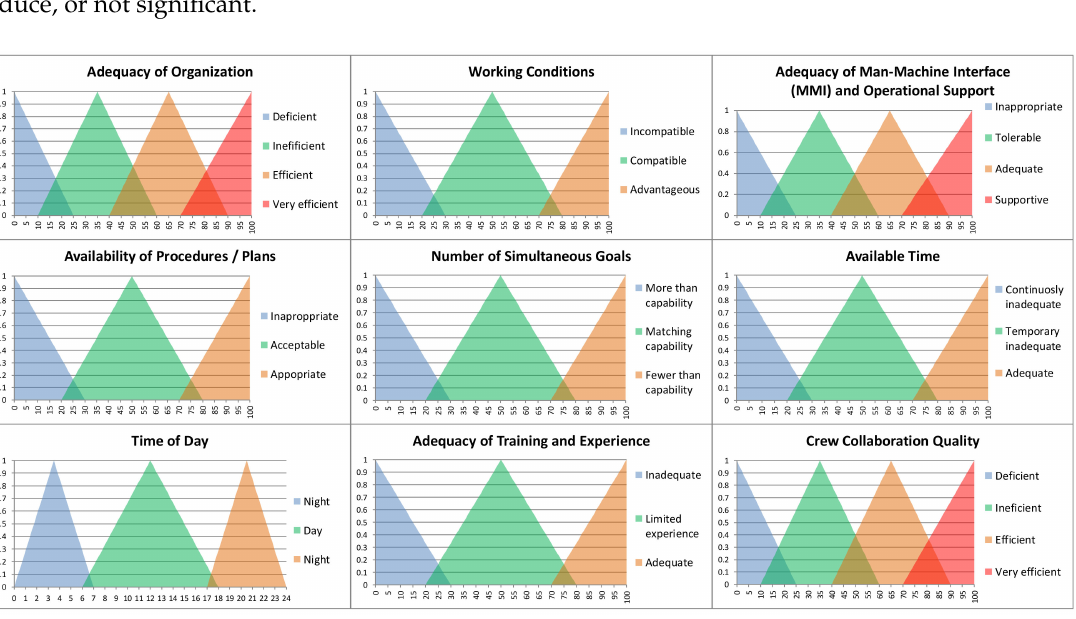
Figure 1. Common performance conditions (CPCs) membership